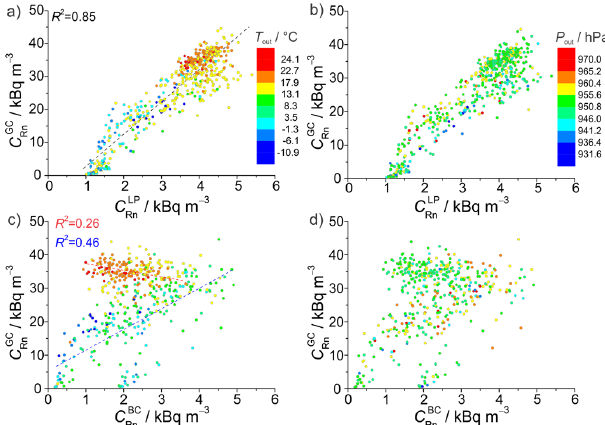
) and Fig. 5. Correlation between radon concentration at GC ( C GC Rn ) depending on: (a) outside air temperature (colour scale) LP ( C LP Rn and (b) atmospheric pressure (colour scale) and correlation between ) depending on: (c) outside radon concentration at GC and BC ( C BC Rn air temperature (colour scale, R 2 for summer and winter period) and (d) atmospheric pressure (colour scale). Daily mean values are